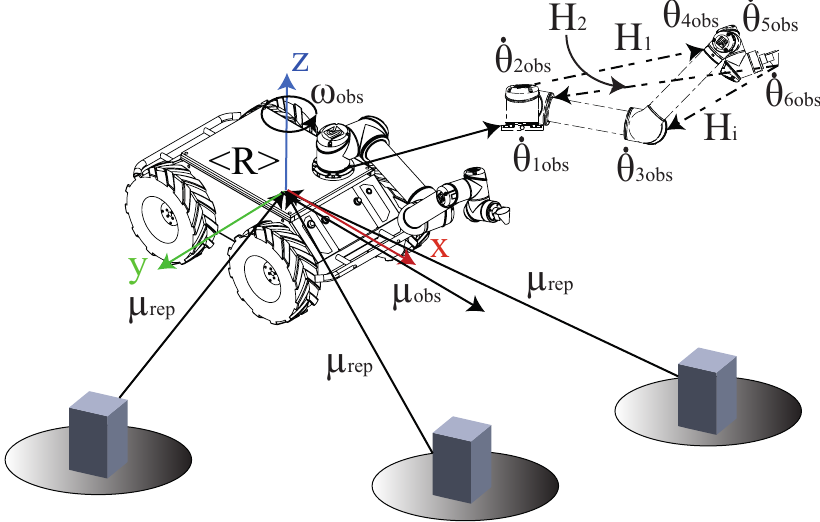
Figure 4. Mobile manipulator with field